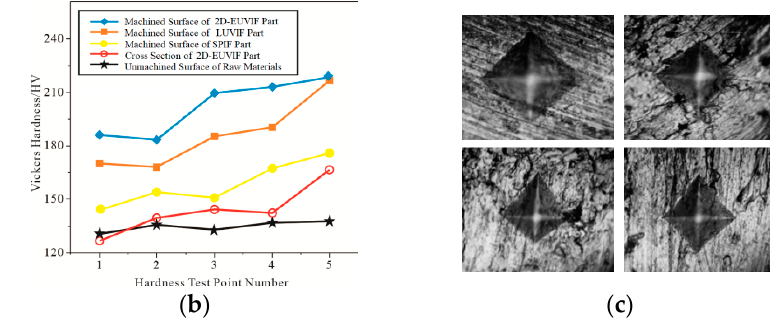
Figure 4. Micro-hardness tests of samples for various forming techniques. ( a ) Hardness testing points; ( b ) hardness curves; ( c ) micro-hardness test images (from upper left to lower right: 7075 aluminum alloy raw material, incremental forming sample, vertical vibrating ultrasonic incremental forming sample, and elliptic vibrating ultrasonic incremental forming sample. Notes: 2D-EUVIF is the abbreviation for 2D ellipse ultrasonic vibration incremental forming; LUVIF is the abbreviation for longitudinal ultrasonic vibration incremental forming; SPIF is the abbreviation for single-point incremental forming). (Notes: The numbers 1–5 in Figure 4a represent accordingly five testing points located equidistantly on the inside wall of the conical part.)